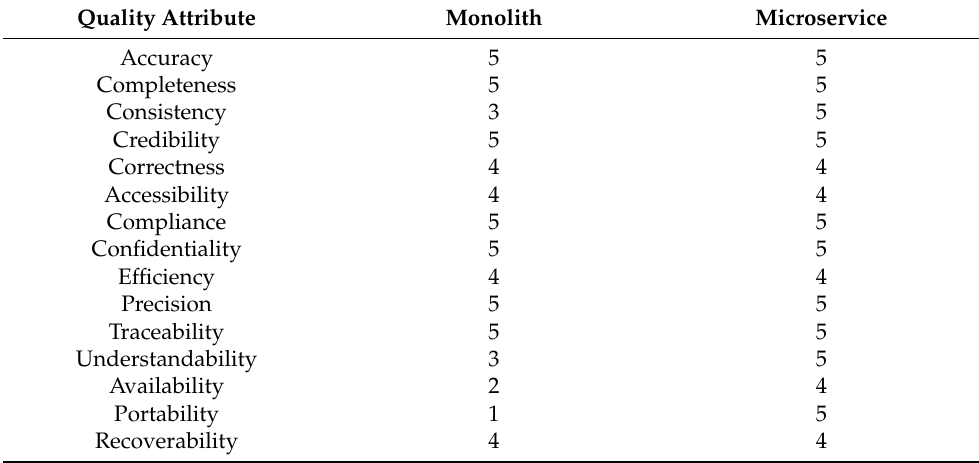
Table 3. The results of the evaluation and comparison of the ISO/IEC 25012:2008 standard quality attributes between the monolith mainframe and microservice